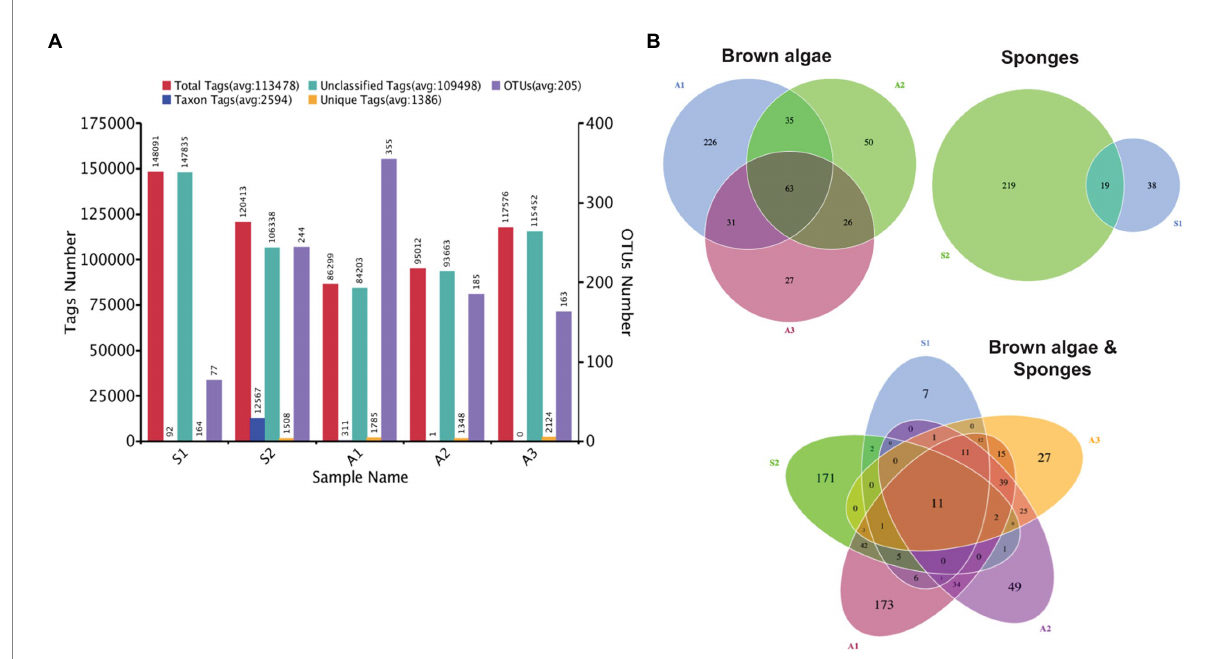
FIGURE 2 Number of tags and operational taxonomic units (OTUs). (A) Summary of the number of tags; total tags, taxon tags, unclassified tags, unique tags, and OTUs of sponge and algae samples. (B) Venn diagrams of shared and unique OTUs between the co-occurring brown algae (top left), sponges (top right), and the five samples (down center) included in this study. Number of OTUs is indicated within each shape.